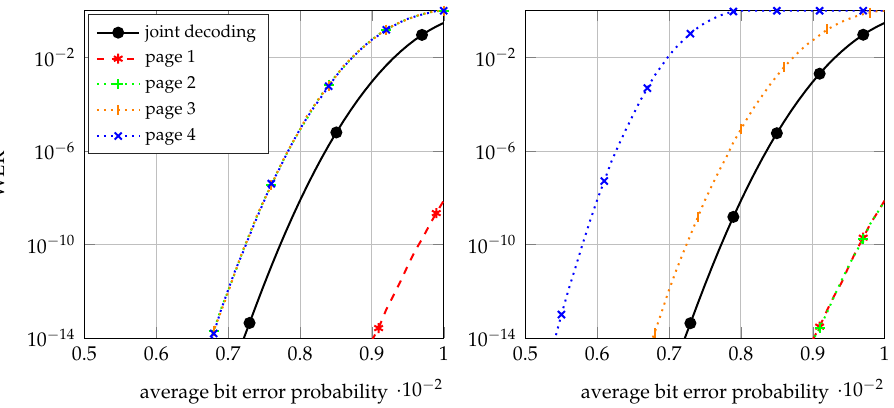
Figure 9. GC codes (from Table 6) of rate R = 0.85 and 4 kB of payload data for a QLC model using Gray code 4 ( left ) and Gray code 5 ( right